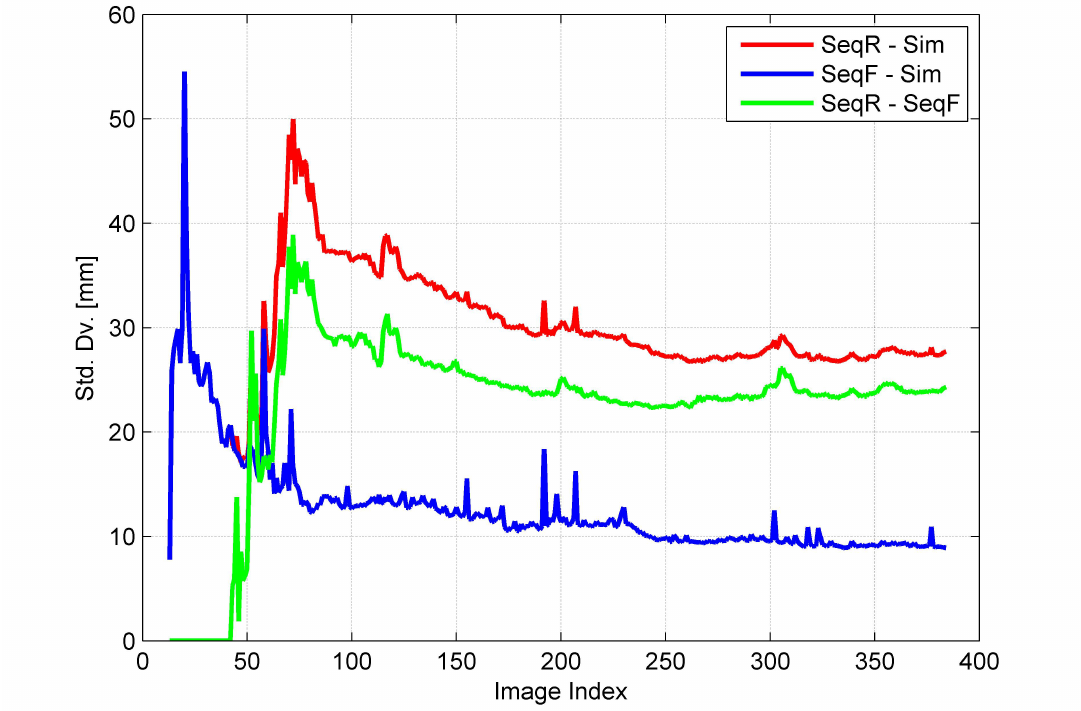
Figure 7. Standard deviation of estimated ground point